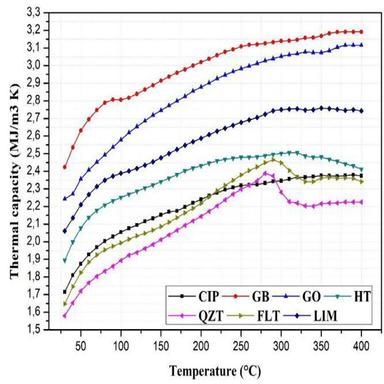
Thermal capacity of the studied rocks vs temperature increase.